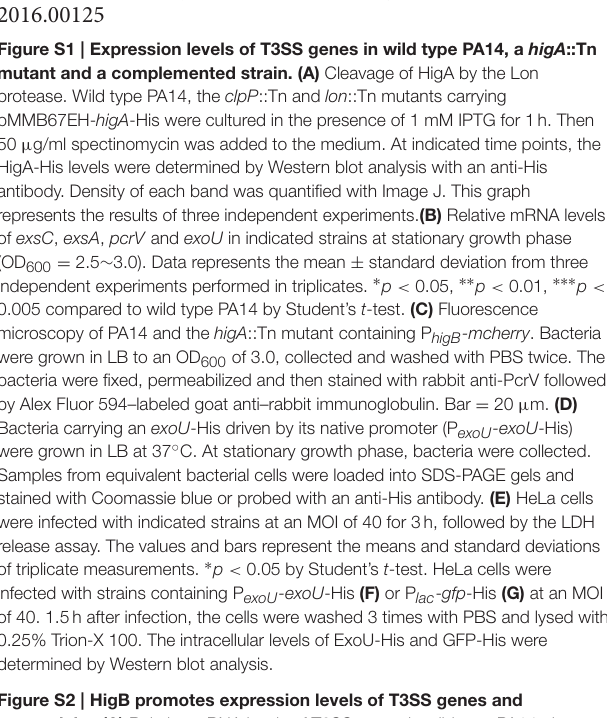
Figure S3 | Fluorescence microscopy of PA14 containing P higB -gfp . At an OD